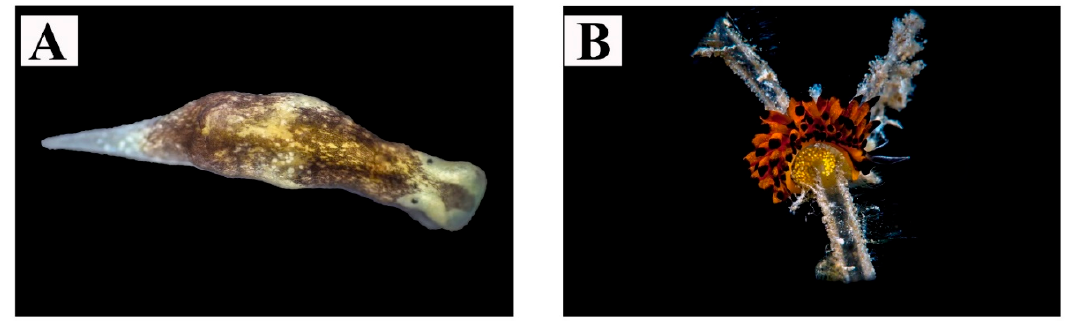
Figure 9. ( A ) Limapontia capitata . St. 24 ( B ) Placida cremoniana . St. Figure 9. A. Limapontia capitata. St. 24 B. Placida cremoniana. St. 1.